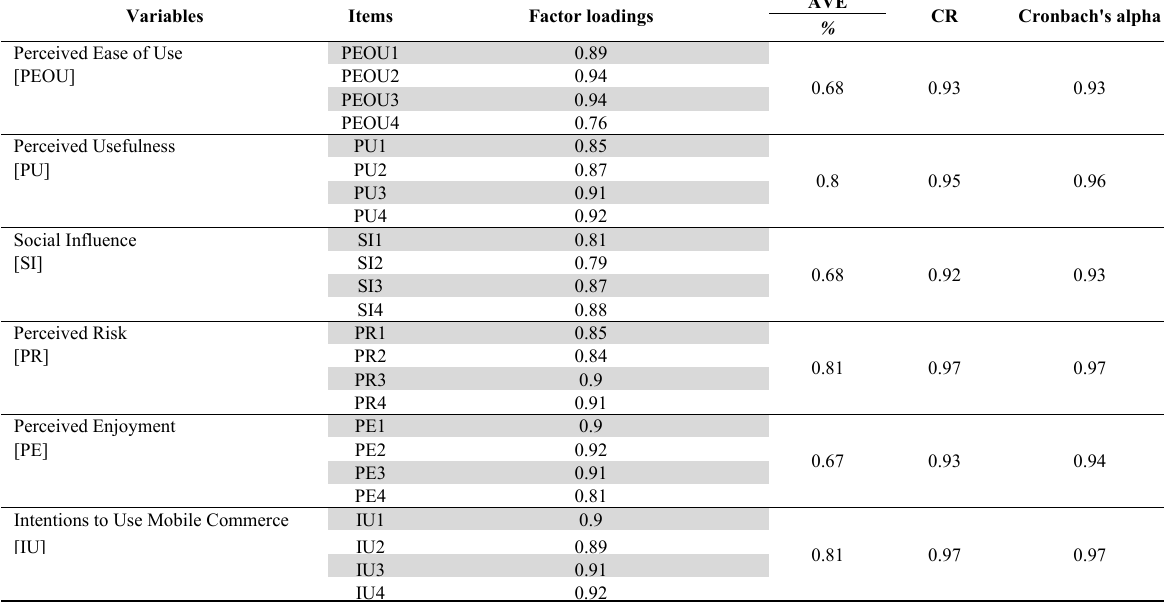
Factor loadings and Construct Validity and Reliability